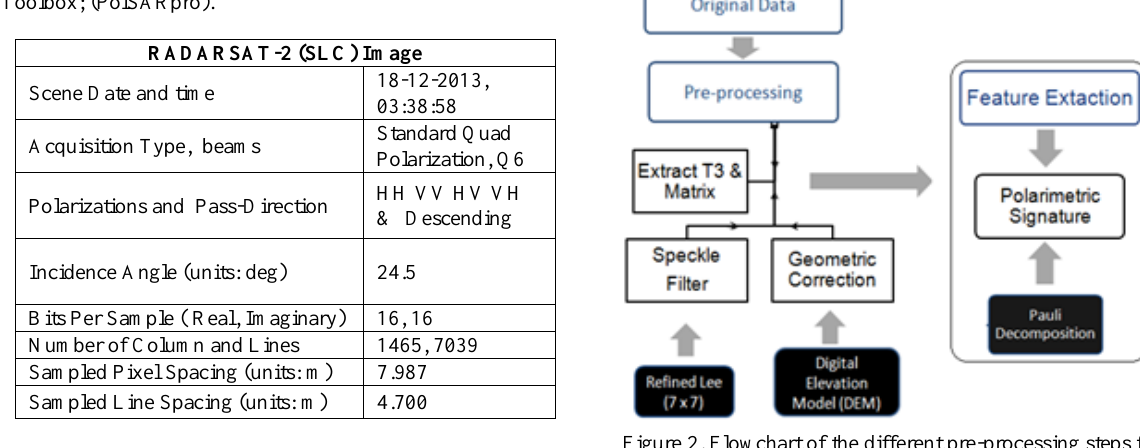
Table 1. Major Characteristics of the Used Radarsat-2